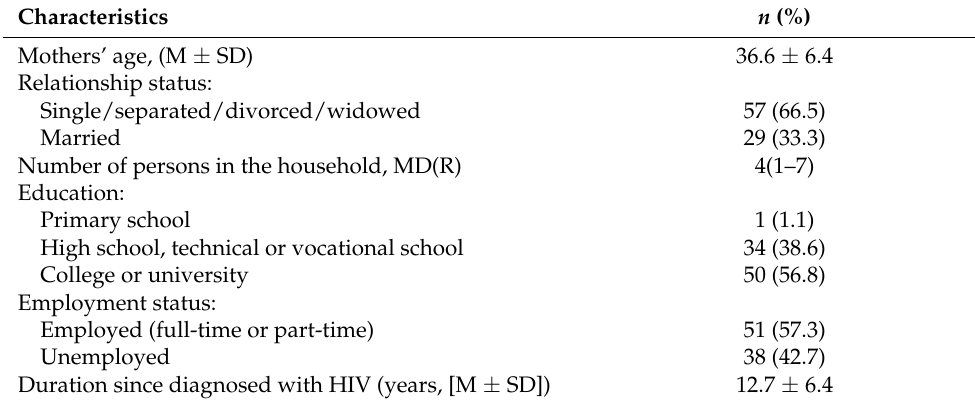
Table 1. Descriptive analysis of participants’ sociodemographic